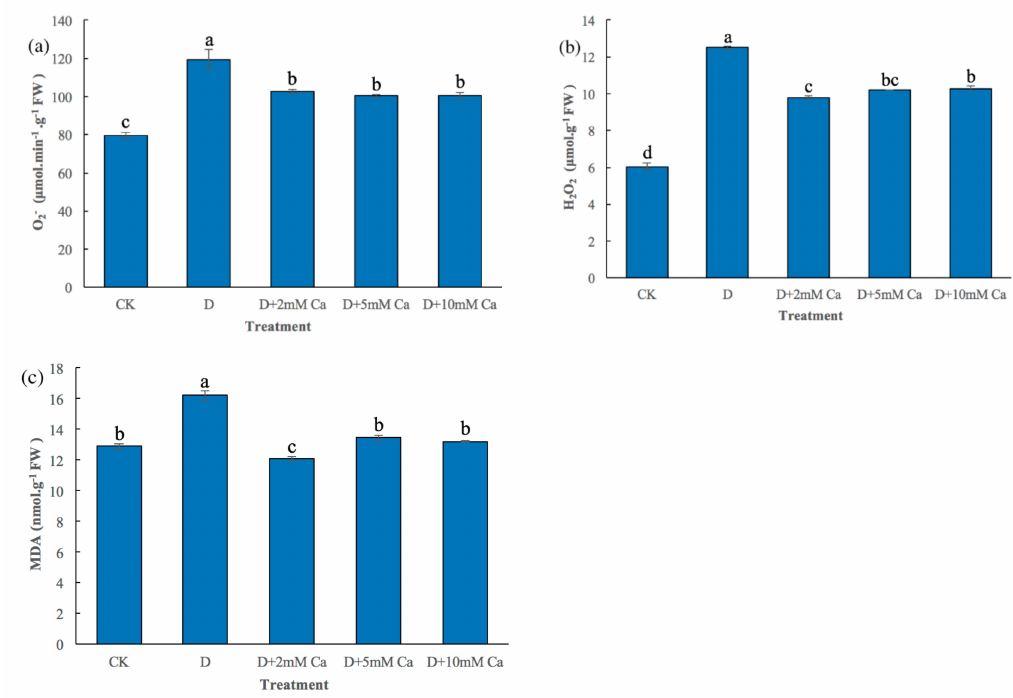
Figure 2. E ff ects of exogenous calcium on the production rates of O2 − ( a ) and H2O2 ( b ) and MDA content ( c ) in H . bodinieri under drought stress. Note: Di ff erent lower case letters indicate a significant di ff erences between treatment within each sampling. time ( p < 0.05). The figure data are the average standard error of the three replicates, and the same is below.